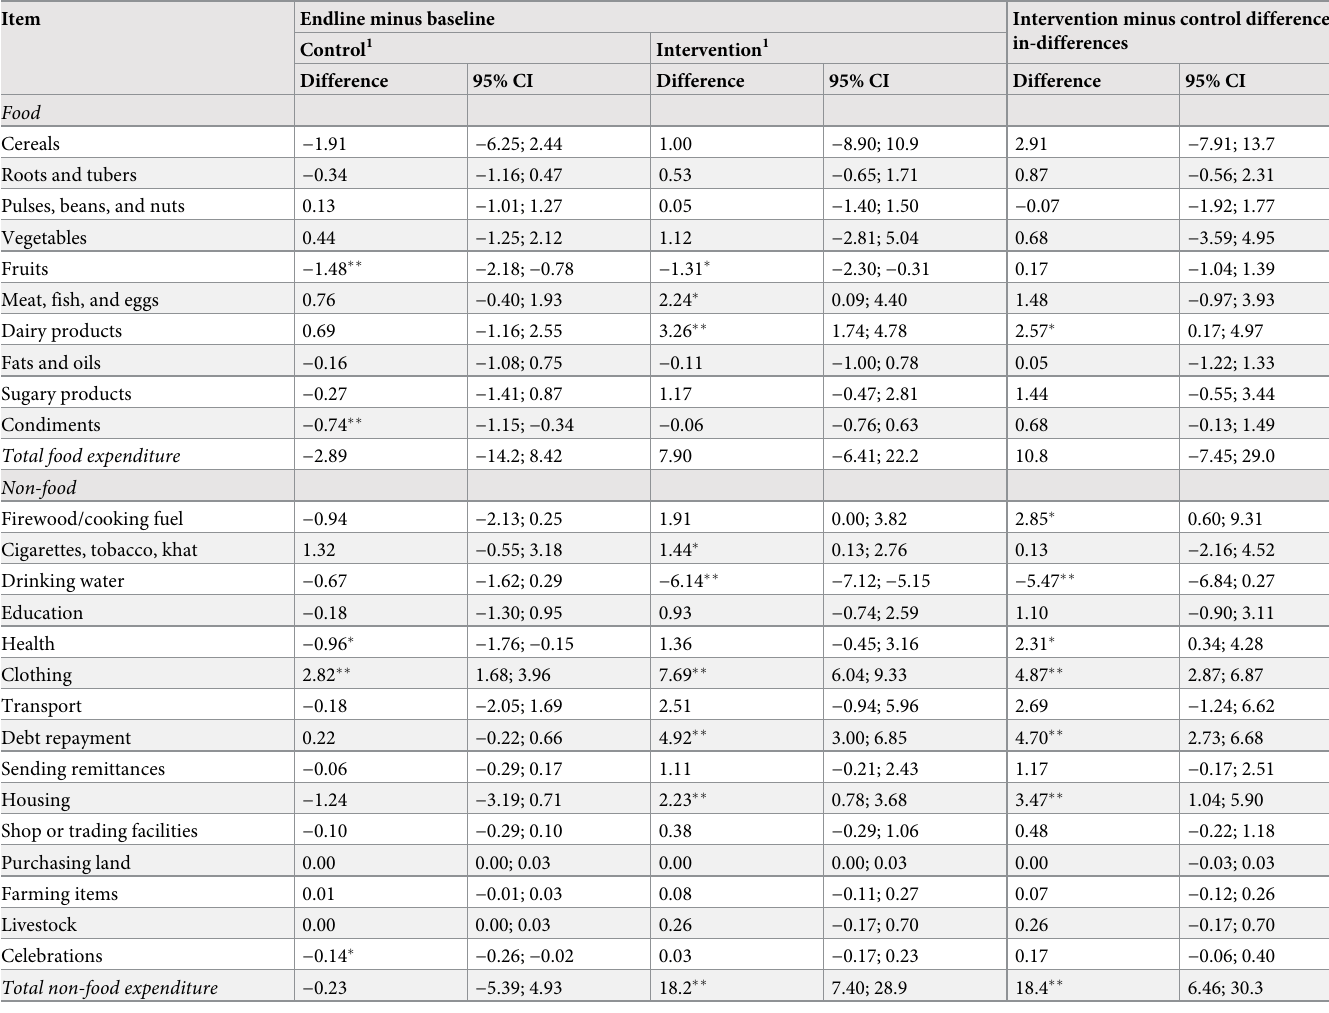
Table 5. Difference between endline and baseline for each study arm and the difference-in-differences for 30-day household expenditure (in US